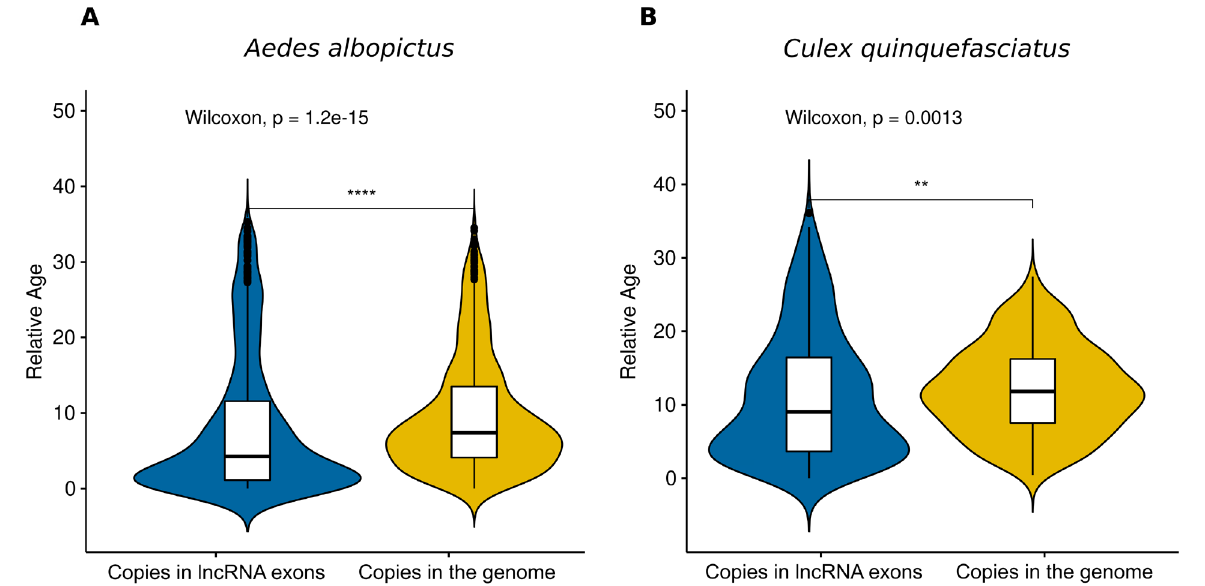
Figure 3 – Relative age for TE copies inside (blues) and outside (yellow) lncRNA exons of Aedes albopictus (A) and Culex quinquefasciatus (B). Relative age was calculated using the blastn divergence of the copies for each TE family against the TE family consensus. ** means a p-value < 0.01, **** means a p-value <